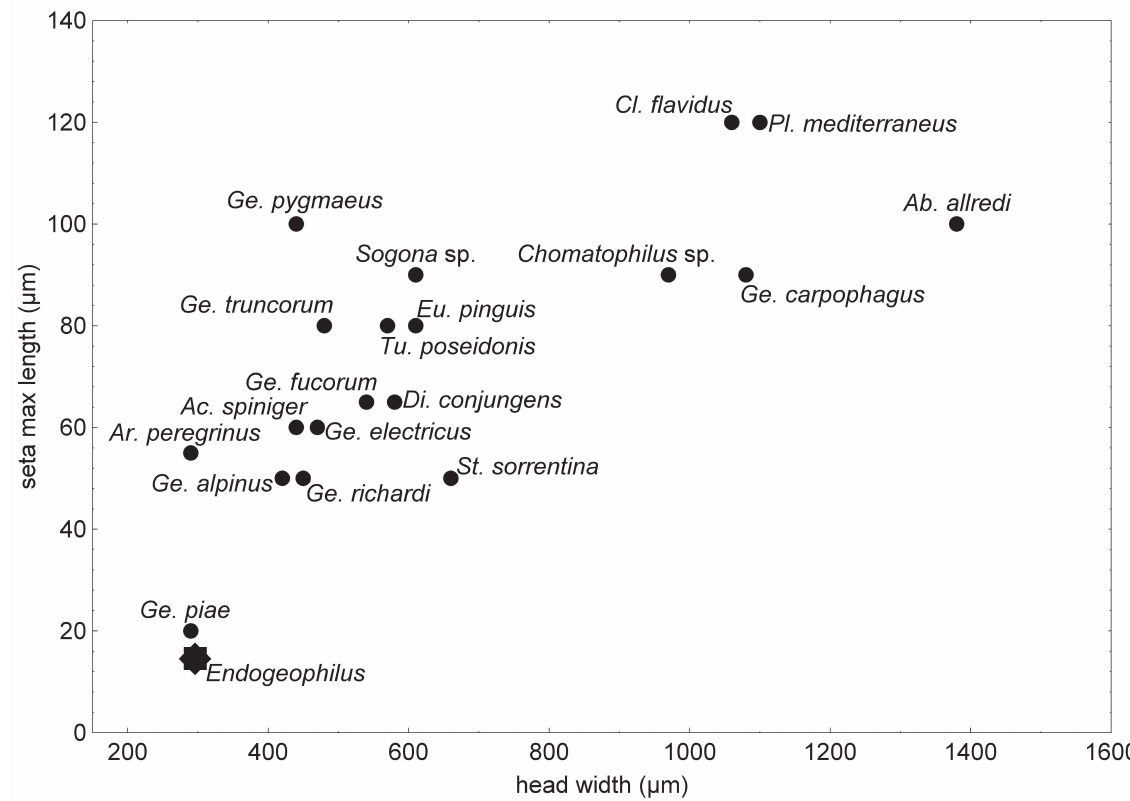
Fig. 8. Variation in the length of setae in a sample of species of Geophilidae, including Endogeophilus ichnusae gen. et sp. nov. The longest seta on the cephalic plate was measured, and the maximum width of the cephalic plate has been taken as a proxy for body size. Full names of species in ‘Material and